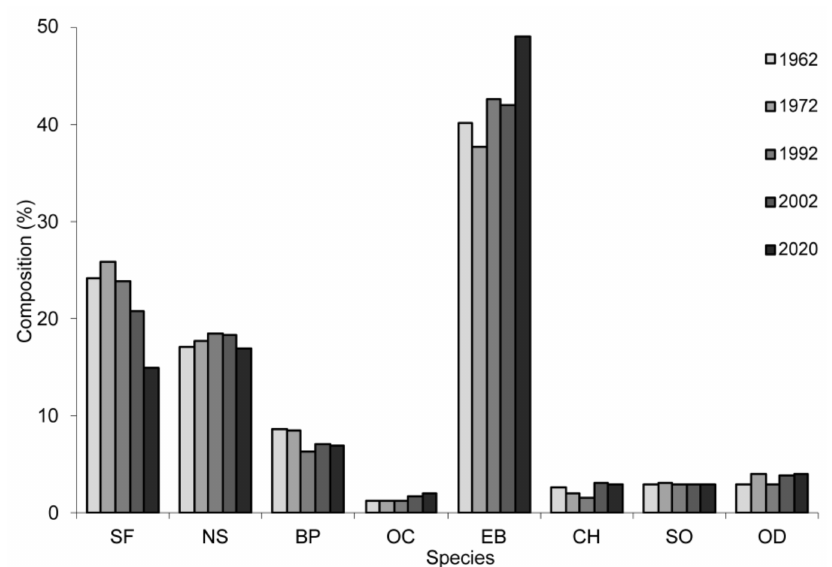
Figure 7. Dynamics of the current composition for 1962–2020 compared to the target composition forecast for 1962 (values extracted from forest management plans). SF—silver fir, NS—Norway spruce, BP—Austrian black pine, OC—other conifers, EB—European beech, CH—common hornbeam, SO—sessile oak, and OD—other deciduous. For 2020, the values came from the composition of the forest determined by inventory. For previous years (i.e., 1962, 1972, 1982, 1992 and 2002), the compositional values came from the management